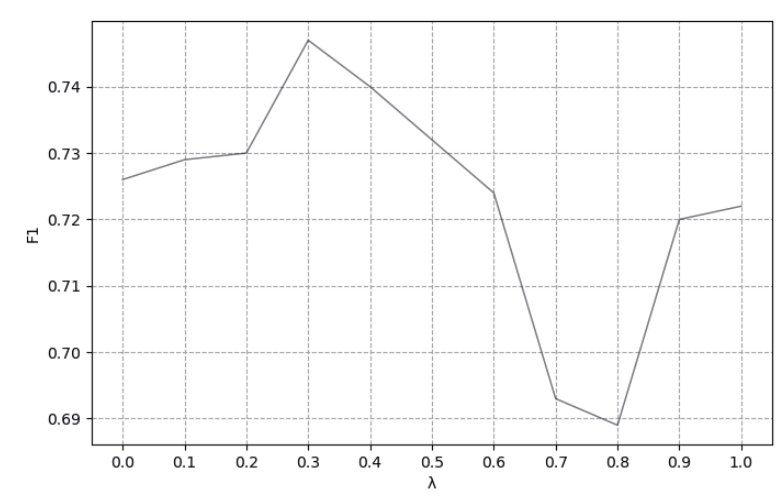
Figure 5. Experimental results on test dataset with different settings of λ .